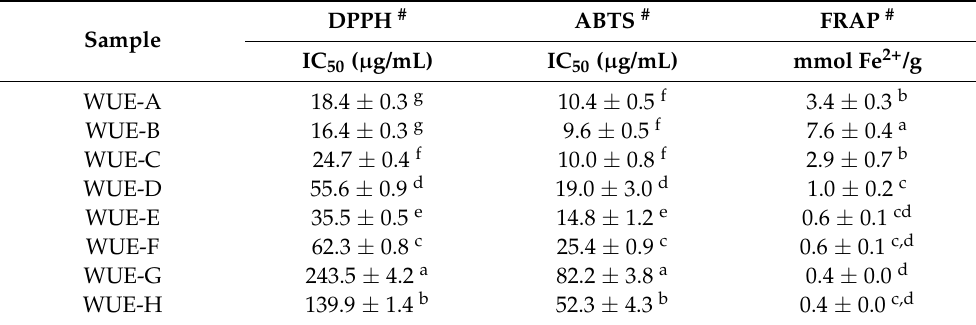
Table 2. Antioxidant activities of different fractions eluted from WUE tested by DPPH, ABTS, and FRAP assays.